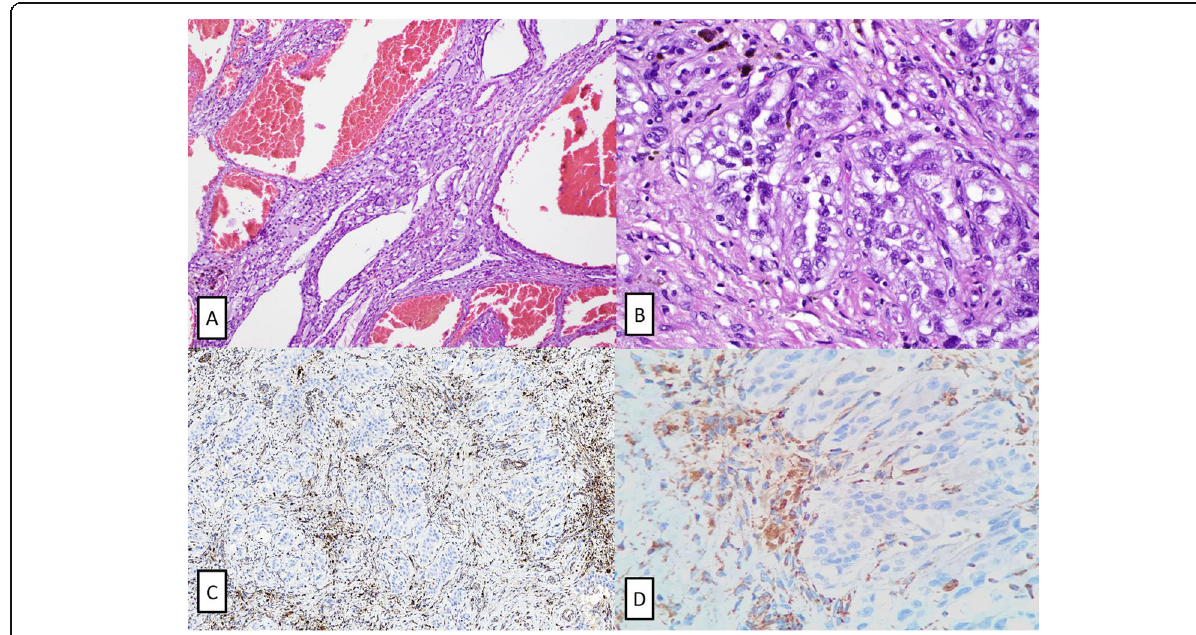
Fig. 4 Fumarate hydratase – deficient renal cell carcinoma. Tubulocystic growth intermixed with a solid component ( a HE, 100x). Higher magnification shows prominent nucleoli ( b HE, 400x). Fumarate hydrase immunostain show loss of cytoplasmatic staining in tumor cells while expression is retaining in adjacent stromal cells ( c and d 40x and